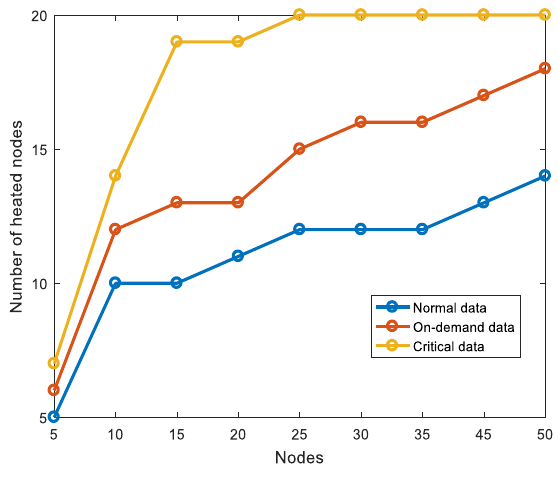
Figure 5. Number of heated nodes.